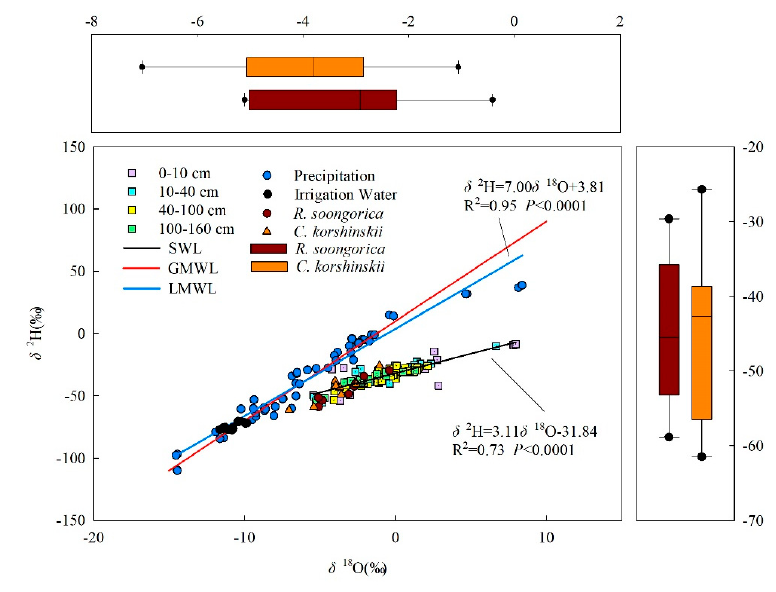
Figure 3. The linear regression relationship between δ 2 H and δ 18 O in soil water, irrigation water and rainfall during the growing season. SWL represents soil water line and is based on isotopic data of soil water ( δ 2 H = 3.11 δ 18 O − 31.84, R 2 = 0.73, P < 0.0001). LMWL represents the local meteoric water line ( δ 2 H = 7.00 δ 18 O + 3.81, R 2 = 0.95, P < 0.0001). GMWL is the global meteoric water line ( δ 2 H = 8 δ 18 O + 10) (Craig, 1961). GMWL are plotted for reference. The isotopic compositions of xylem water from two shrubs are shown in the figure.